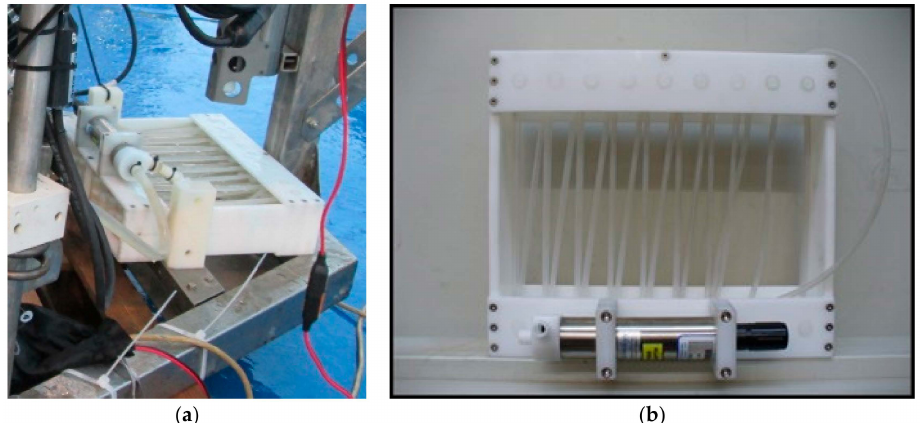
Figure 10. The OxyStat oxygen replacement device. ( a ) The pump and the tube connected to the interior of the chamber; ( b ) view from